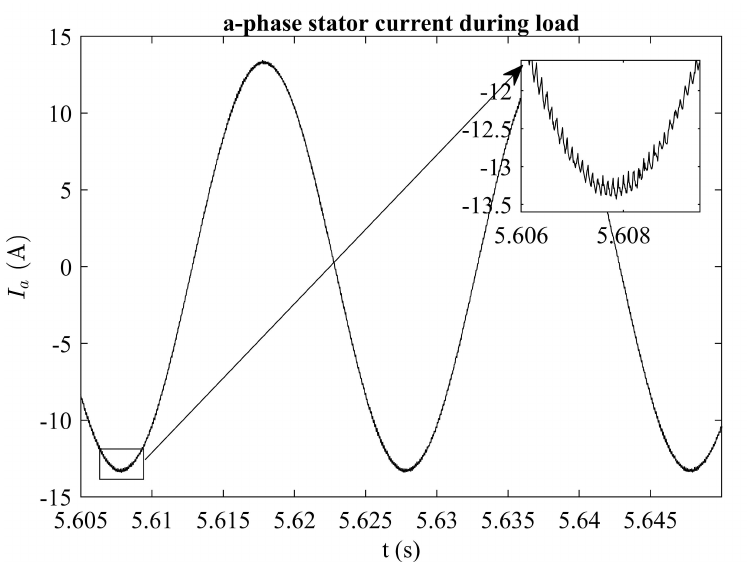
Figure 8. abc-phase stator currents at startup.